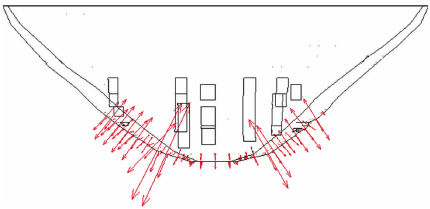
Figure 13: Distribution of unbalanced force in dam of scheme 1.